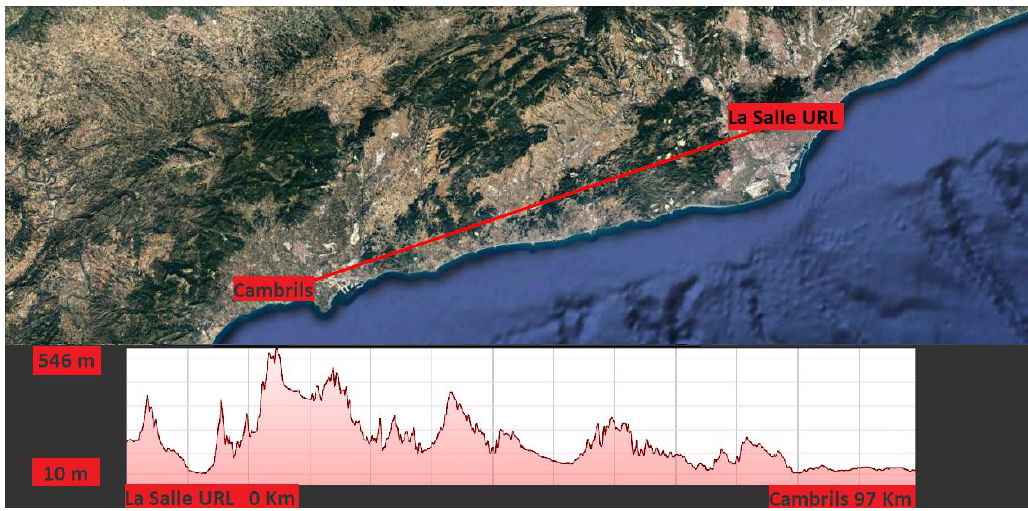
Figure 3. Barcelona-Cambrils Figure 3 . Barcelona-Cambrils link .